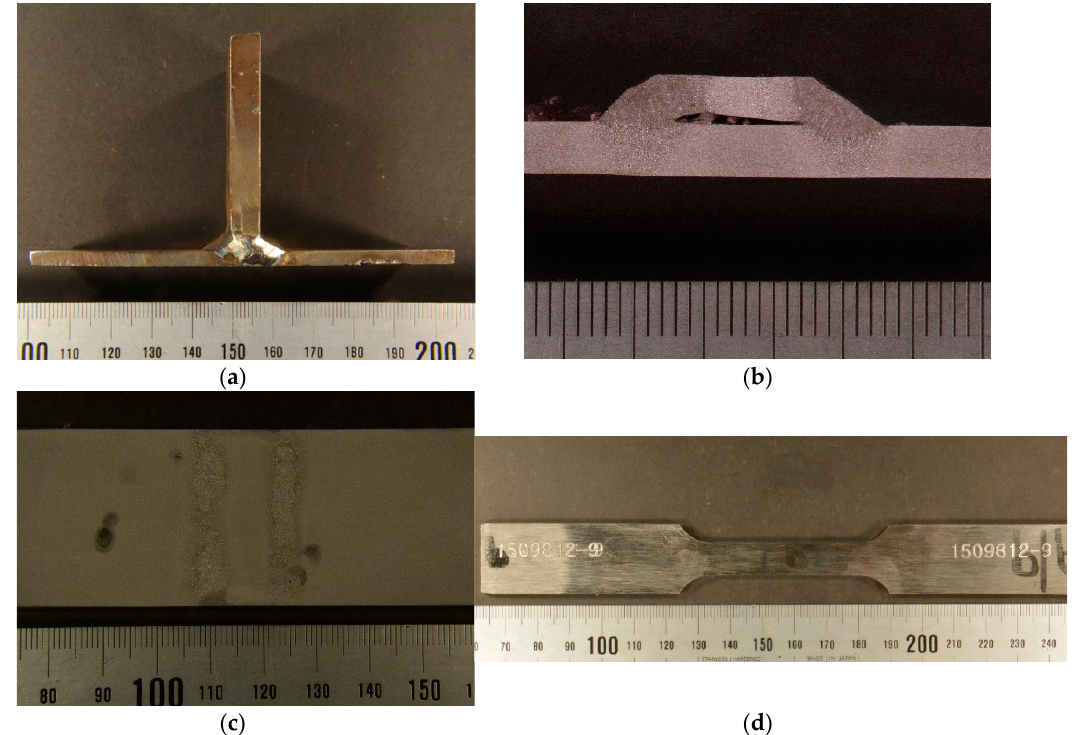
Figure 2. Opposed twin fillet welded joint of 8 mm plate to 4 mm tube test specimens: ( a ) As welded coupon; ( b ) Macrographic examination of the welded coupon shown in figure ( a ); ( c ) Machined and etched welded coupon after 8 mm plate removal; ( d ) Tensile test specimen.